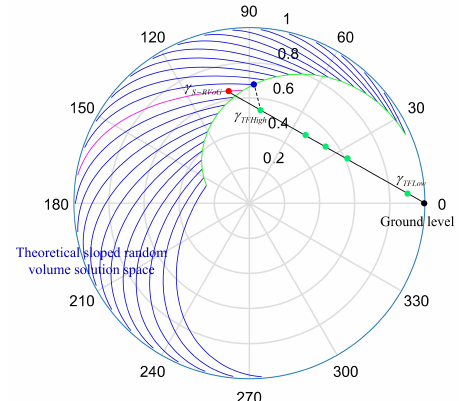
Figure 5. The schematic representation of the S-RVoG model inversion: The parameter setting of the theoretical sloped random volume cohernce is consistent with Figure 4a (corresponding to a 5 deg terrain slope). The pink curve represents the volume coherences corresponding to a 19-m forest height based on the S-RVoG model while the green curve represents the volume coherences for a 0 dB/m extinction. The green dots denote the coherence estimation. The blue dot indicates the predicted volume coherence. The black dotted line represents the minimum route between γ TFH igh and the solution